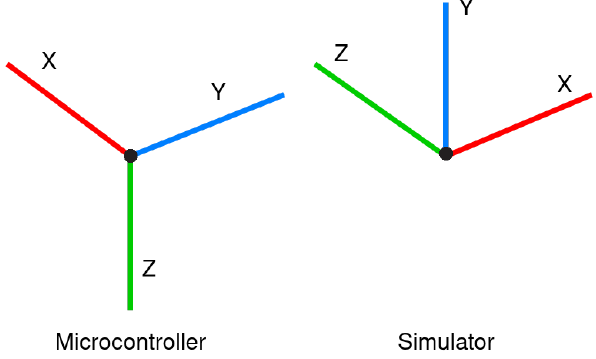
Figure 6. Microcontroller and simulator frames of